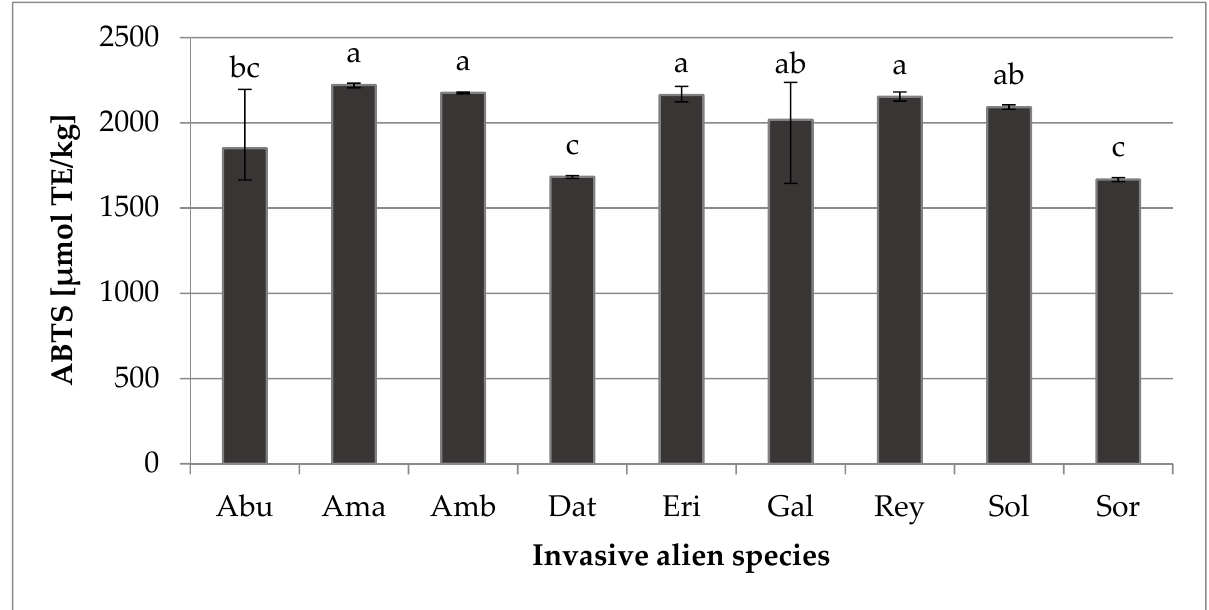
Figure 3. ABTS—antioxidant capacity (µmol TE/kg) of nine different invasive alien species. Abu— Abutilon theophrasti ; Ama— Amaranthus retroflexus ; Amb— Ambrosia artemisiifolia ; Dat— Datura stramonium ; Eri— Erigeron annuus ; Gal— Galinsoga ciliata ; Rey— Reynoutria japonica ; Sol— Solidago gigantea ; Sor— Sorghum halepense . Different letters (a–c) indicate significant differences between means at p ≤ 0.0001.